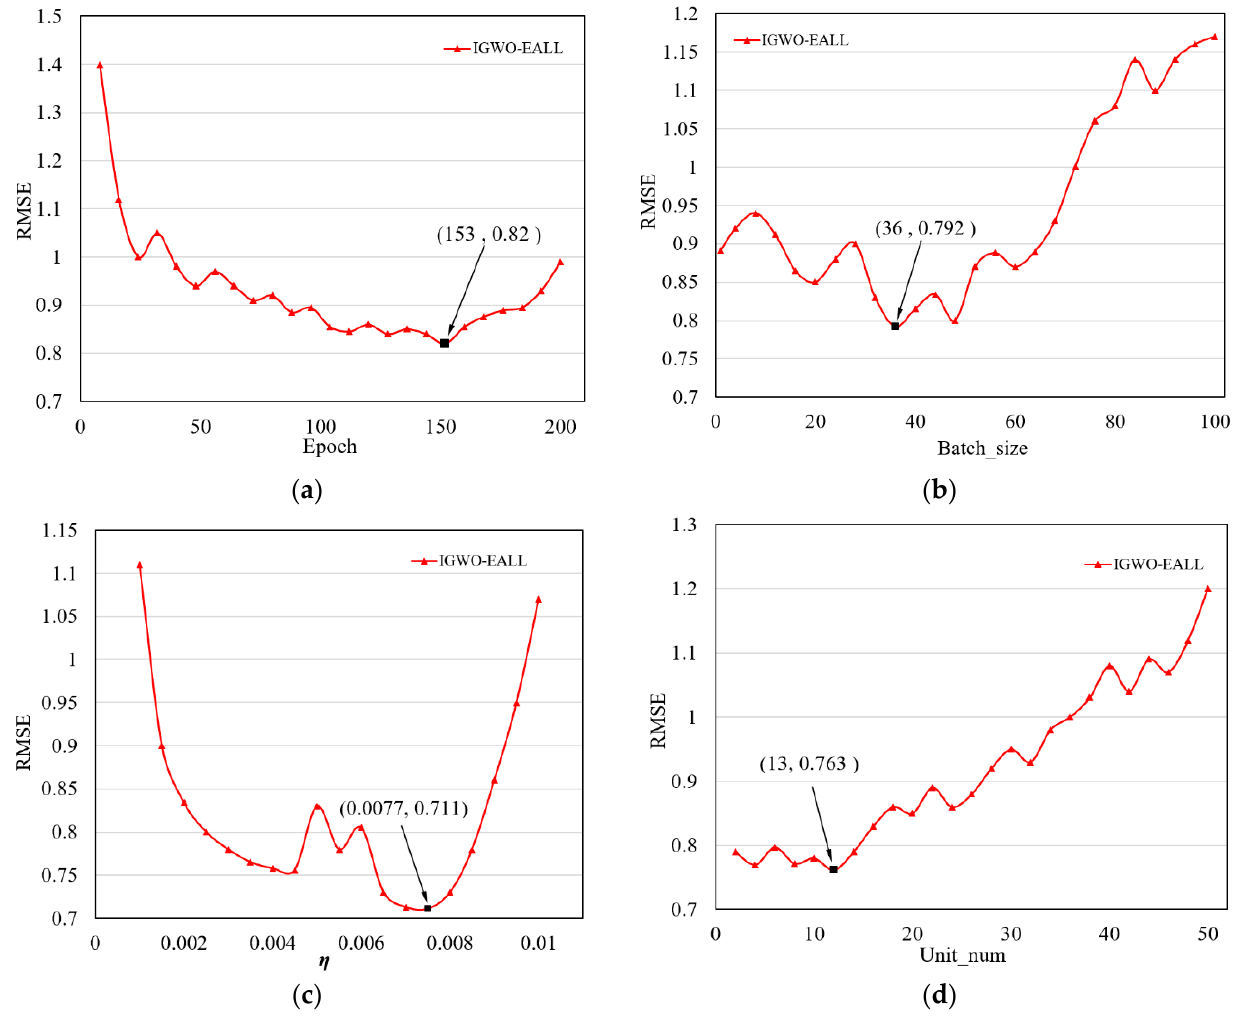
Figure 9. Variation curve of training times and RMSE value of prediction results: ( a ) variation curve